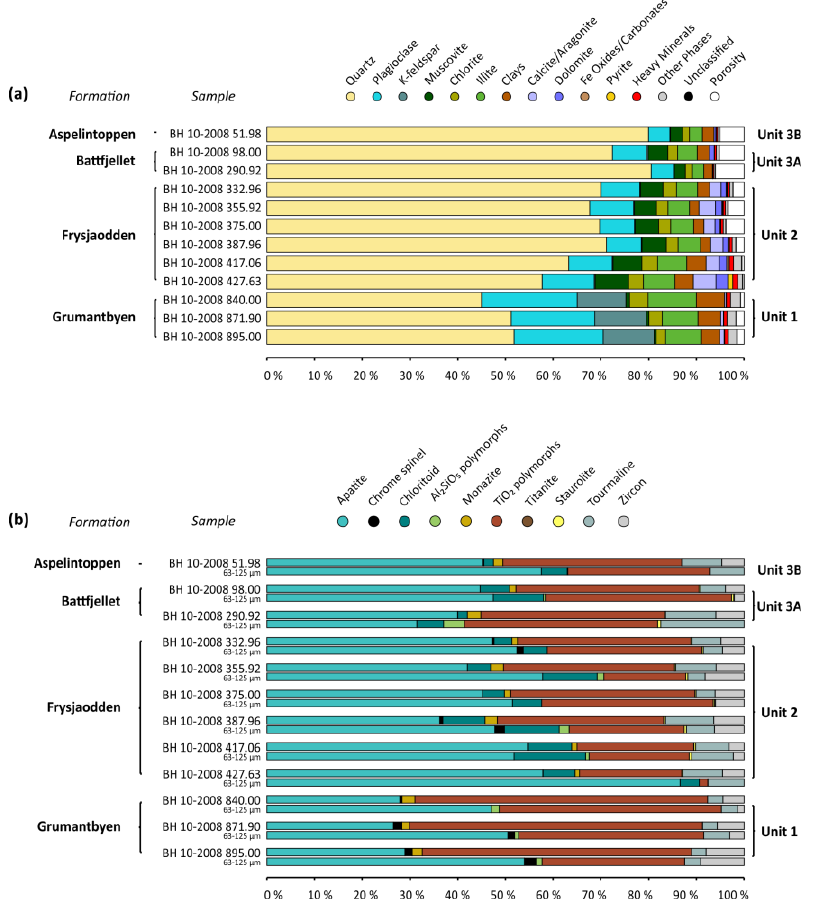
Figure 6. QEMSCAN data ( a ) normalised bar chart showing the modal mineral assemblage, and ( b ) normalised bar charts of the heavy mineral assemblage where for each sample the top bar chart represents the percent area of all grains >5 μm (the resolution of the QEMSCAN images) and the bottom bar chart represents percent area of grains with long axes between 63 and 125 μm.